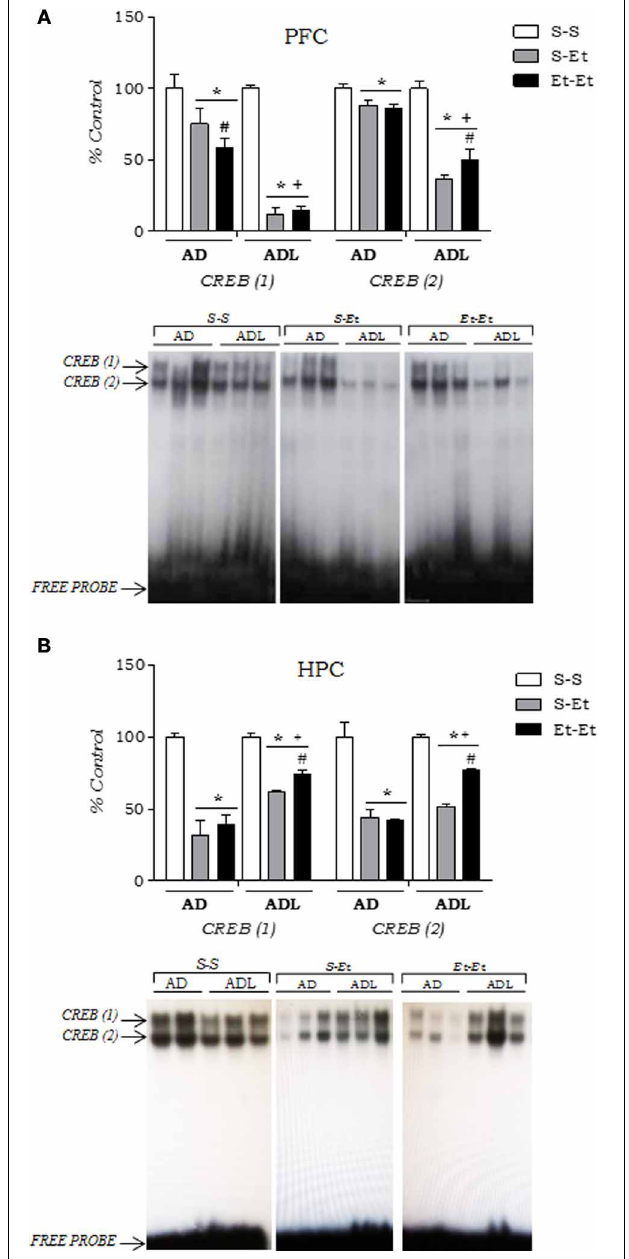
FIGURE 5 | CREB activation induced by acute or repeated ethanol treatment in the (A) prefrontal cortex (PFC) and (B) hippocampus. An EMSA was performed with nuclear extracts (15 μ g) from the PFC in adult (AD) and adolescent (ADL) mice assessed for behavioral sensitization to ethanol (2.0g/kg), 3h after the ethanol challenge (day 22); ( n = 4/group). A representative autoradiograph is shown. Each bar represents the percentage (mean ± s.e.m.) of the results obtained in tissues from the respective control group (S-S). ∗ p < 0 . 01, different from the respective control group (S-S); + p < 0 . 01, different from the respective treatment compared to the adult group; # p < 0 . 01, different from the respective acute group (S-Et; Two-Way ANOVA followed by Newman-Keuls post-hoc test). S-S, control; S-Et, acute ethanol; Et-Et, repeated